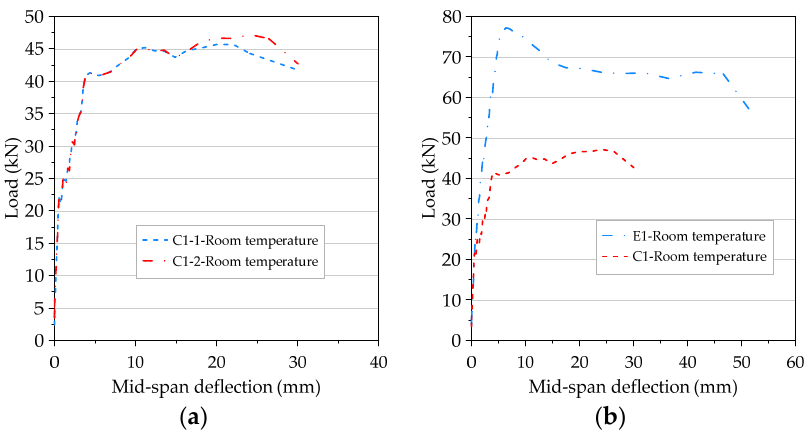
Figure 18. The load–deflection curve of beam: ( a ) the control group at room temperature and ( b ) comparison of the two groups at room temperature.